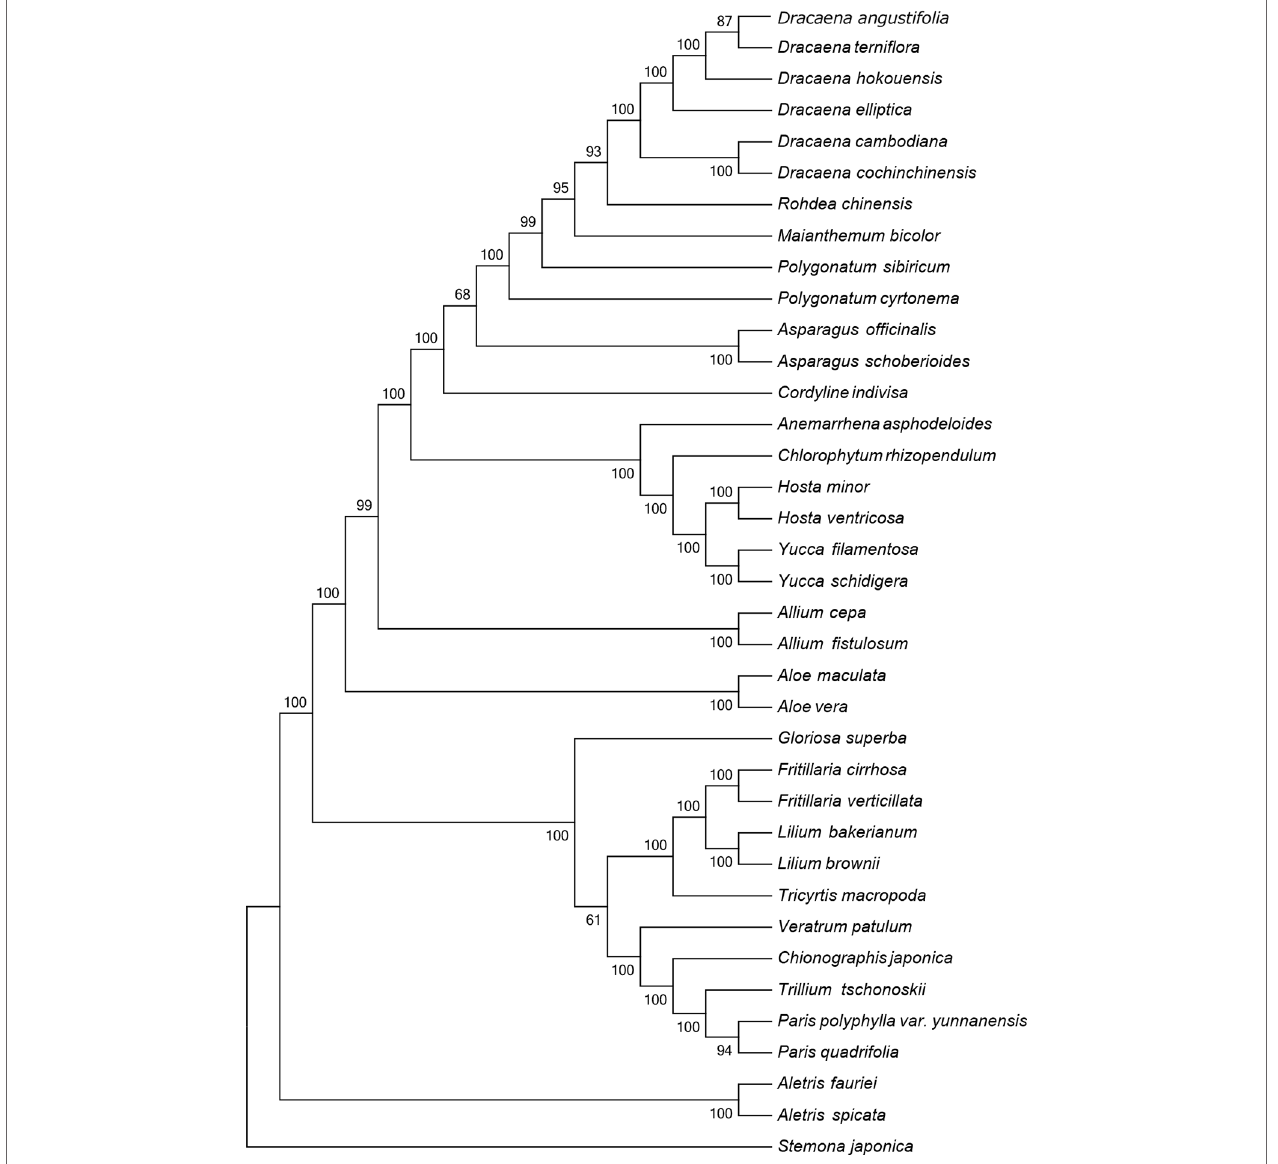
FIGURe 4 | Phylogenetic tree constructed using maximum parsimony (MP) based on complete CP genomes of six Dracaena and other 31 species. Numbers above the branches are the bootstrap support values.